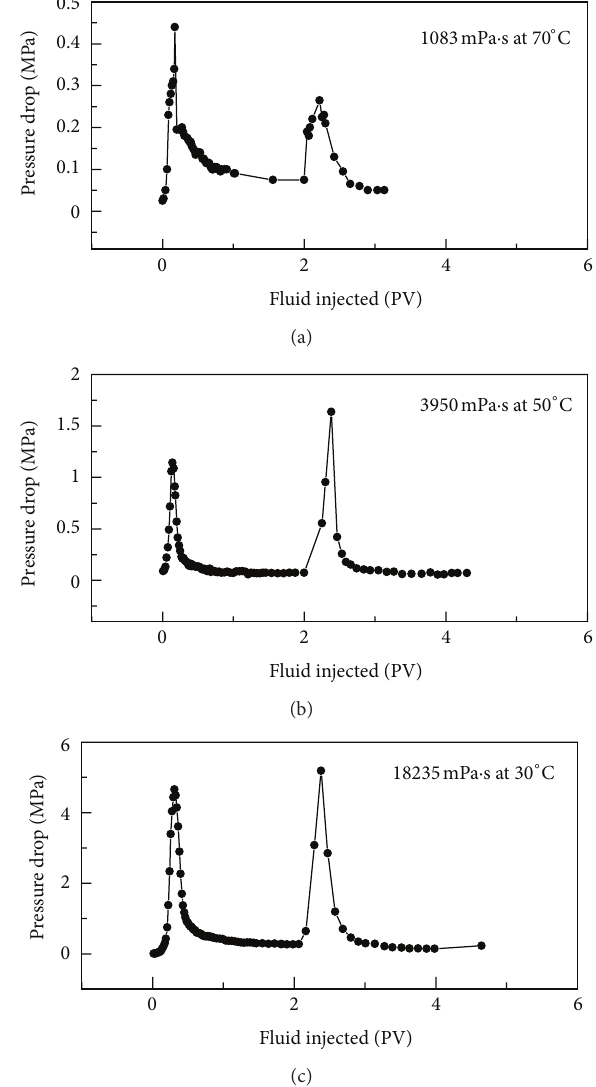
Figure 7: Pressure changes during alkaline flooding for Xia-8 heavy oil with different